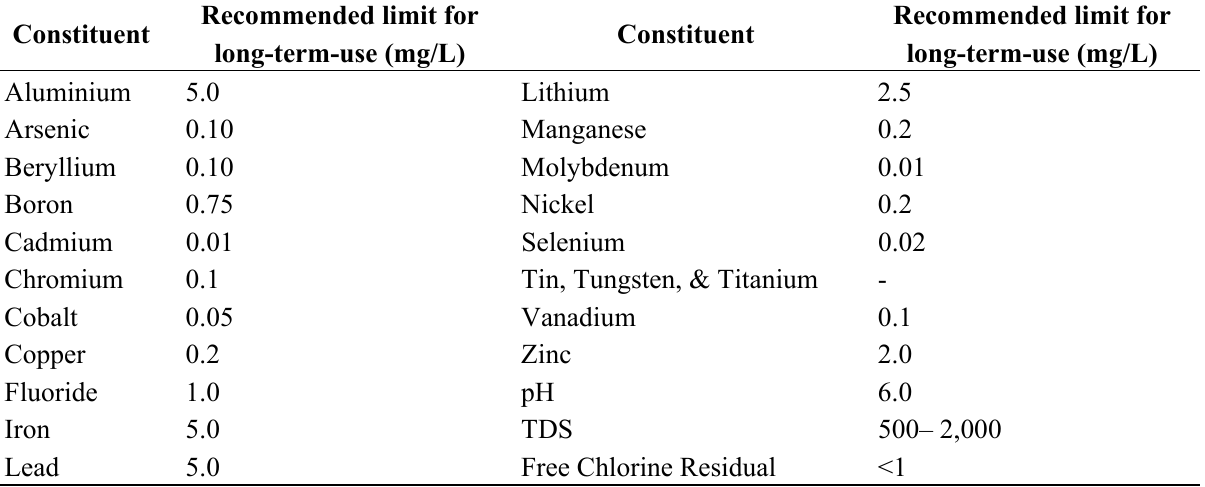
Table 9. Recommended limits for constituents in reclaimed water for irrigation (modified from